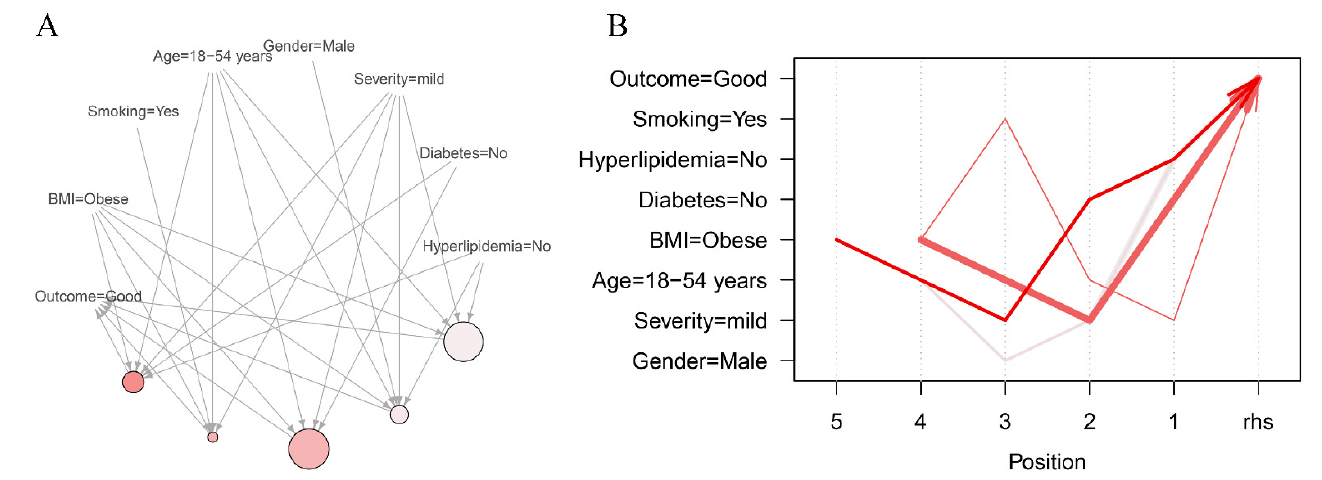
Figure 2. Visualization of significant association rules in patients with acute ischemic stroke, via fp-growth algorithm with minimum support (0.04) and confidence (0.8). ( A ) Network of significant association rules. ( B ) Parallel coordination plot for significant association rules. In the Figure 2A,B, thickness and redness of the lines means support and confidence of the association rules. BMI, body mass index; CE, cardioembolism; rhs, right hand side.